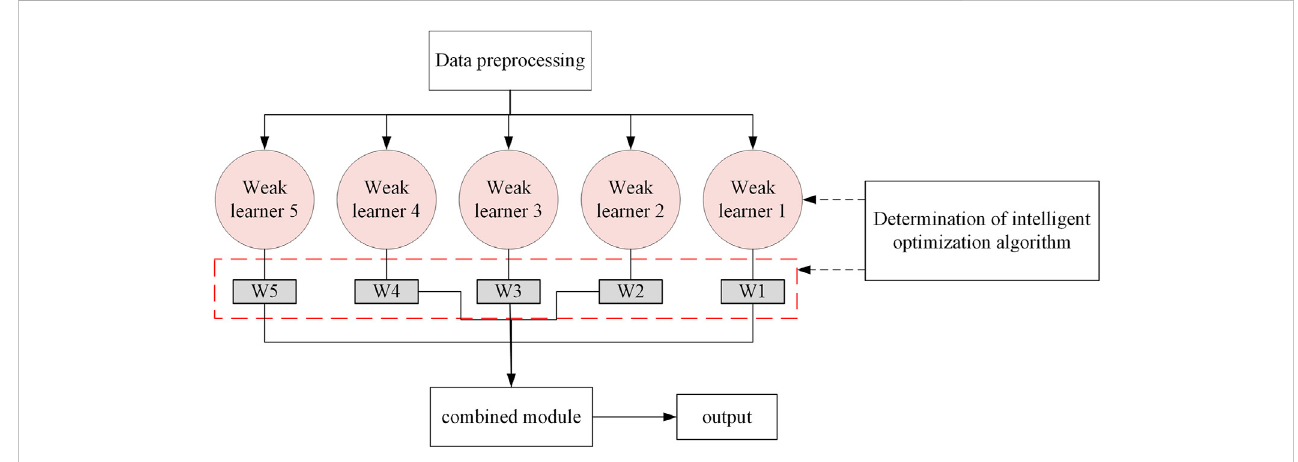
FIGURE 2 IN-Voting network structure (W in the fi gure indicates the weight value).